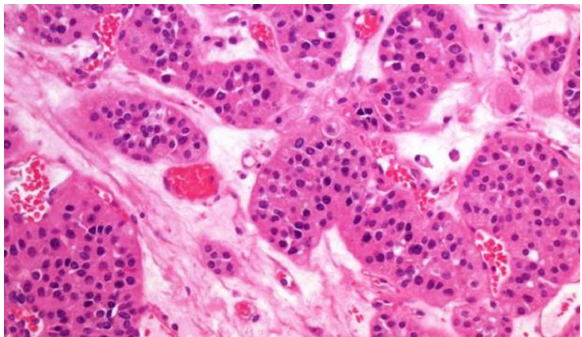
Figure 2: Histopathology section of the excised specimen demonstrating round and polygonal cells packeted within a loose stromal background, eosinophilic and finely granular cytoplasm, round nuclei with inconspicuous nucleoli, and absent or rare mitotic figures consistent with a diagnosis of renal oncocytoma (H and E, ×